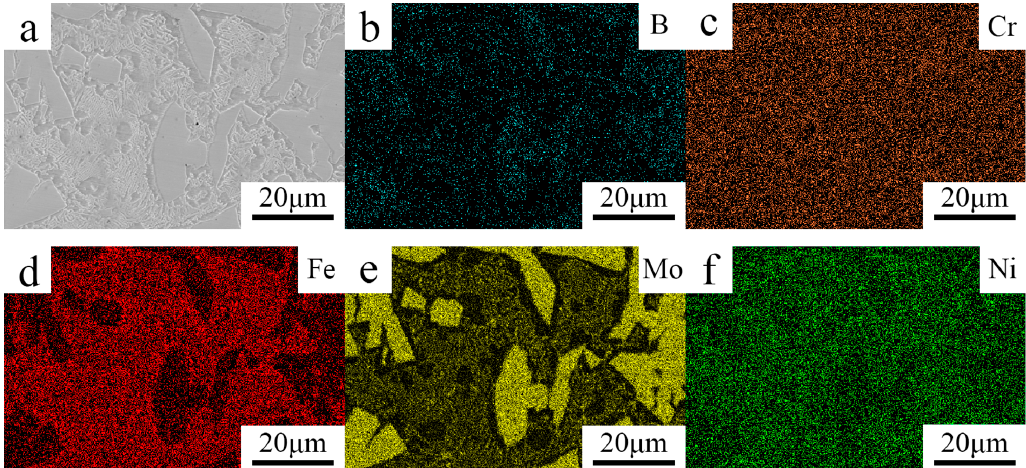
Figure 7. Elemental distribution maps of the Fe–Cr–Mo–Ni–B coating: ( a ) SEM image; ( b ) B; ( c ) Cr; ( d ) Fe; ( e ) Mo; ( f ) Ni.